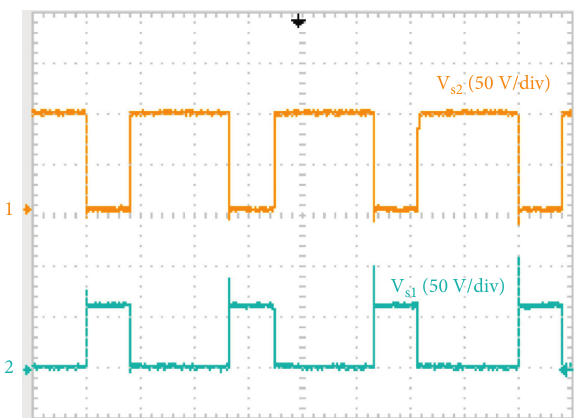
Figure 22: Voltage stress on switches V S1 (channel 2) and V S2 (channel 1) in boost mode operation of the converter.